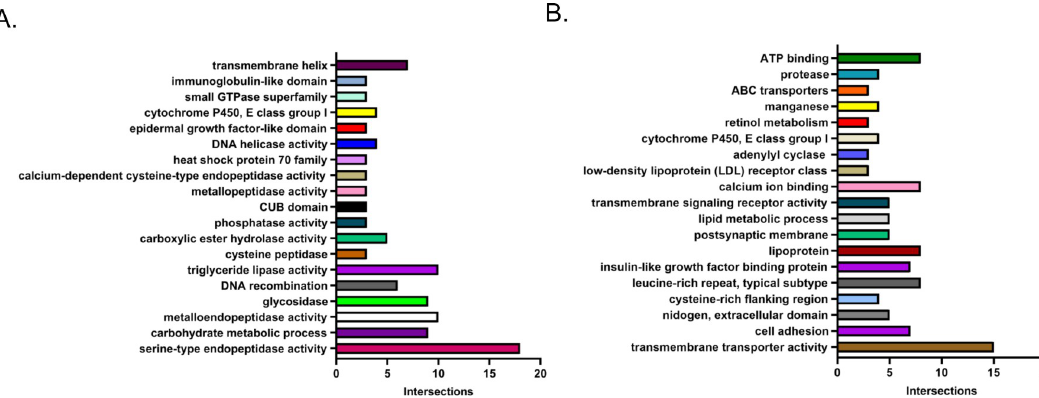
Fig 7. DAVID Annotation Clustering reveals genes with catalytic activity and membrane components that are differentially expressed in LD-Aag2 cells. (A) Upregulated LD-Aag2 genes associated with catalytic activity were grouped into 19 clusters ( B) Upregulated LD-Aag2 genes associated with membrane or intrinsic component of membrane were grouped into 19